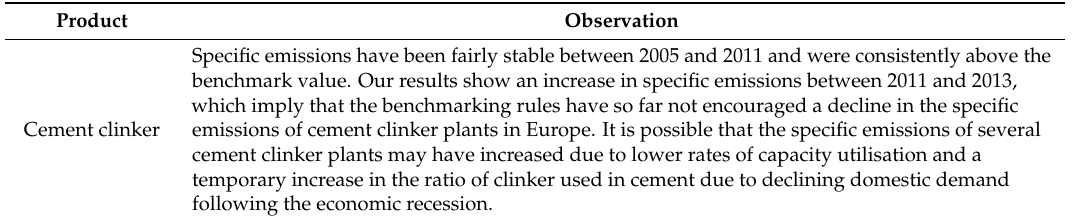
Table 4. Summary of results for the four case studies (cement clinker, pig iron, ammonia and nitric